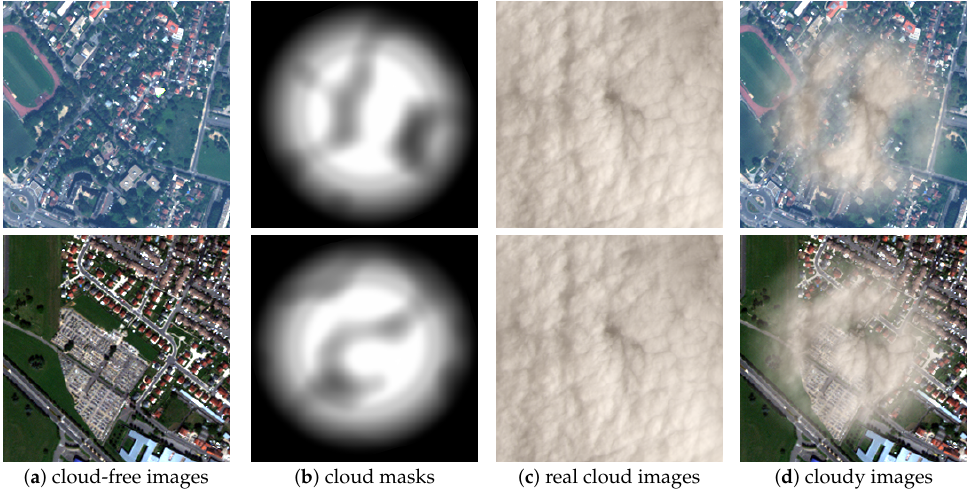
Figure 14. Two samples from the Paris